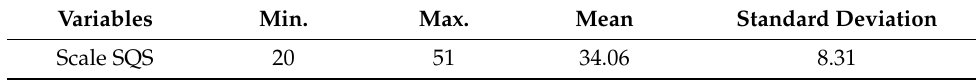
Table 2. Values (extreme, mean, and standard deviation) for SQS.